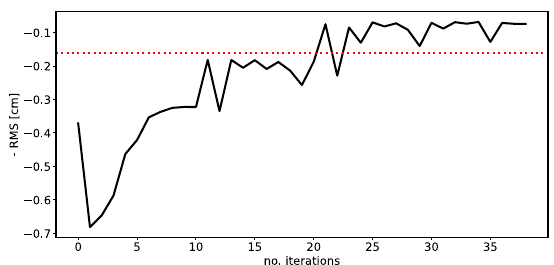
FIG. 5. Results of numerical optimization with the COBYLA algorithm on the simulated OpenAI Gym environment for AWAKE steering. With the hyperparameters used for launching the algorithm, it took 37 iterations to converge at an RMS of 0.5 mm. It would however have reached the OpenAI Gym environment threshold (indicated in red) already after 21 iter- ations. The threshold in the OpenAI Gym environment was set to 1.6 mm RMS. The results on the y-axis are shown in the same units as for the plots on the RL results